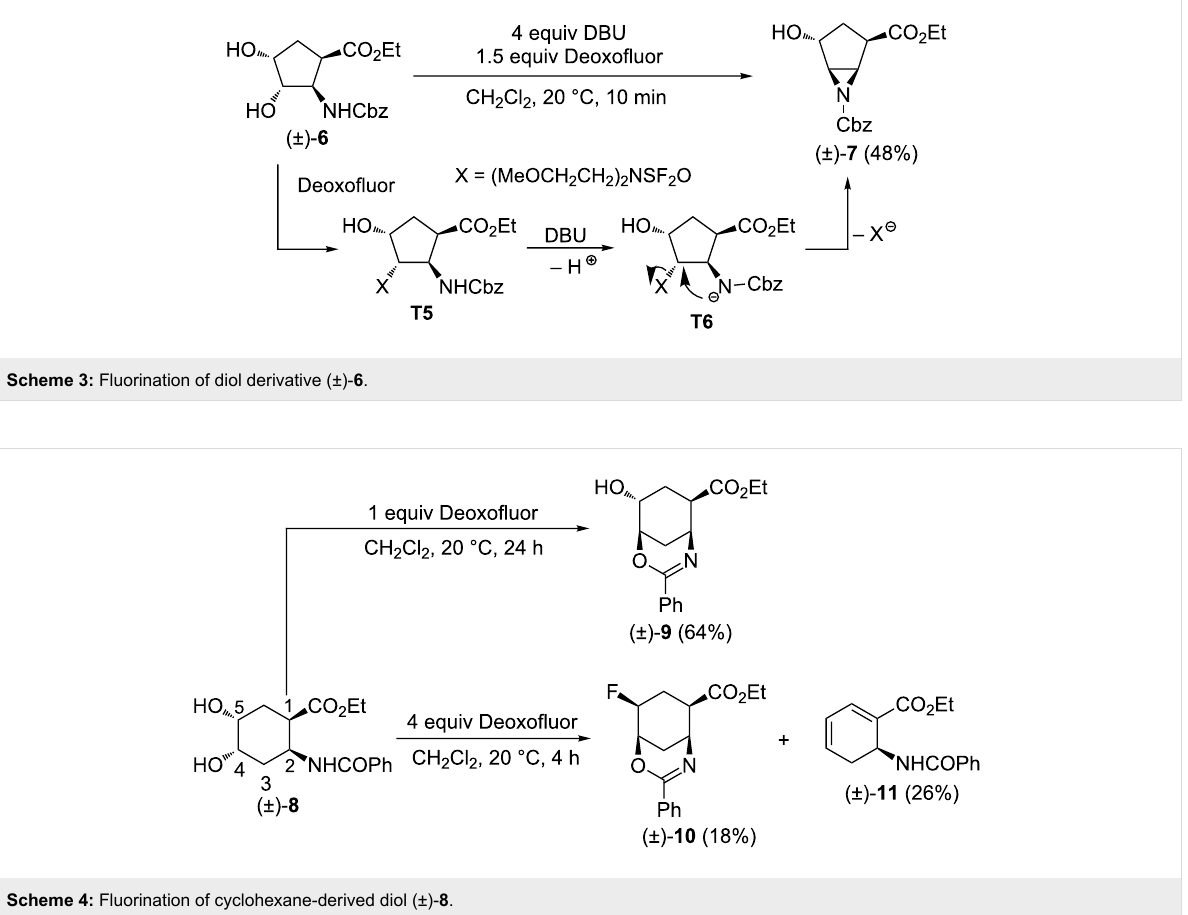
alcoholic group at C-4 in (±)- 8 into a leaving group, an intramo- lecular cyclization takes place to afford oxazine (±)- 9 . Subse- quently, this oxazine, in the presence of an excess Deoxofluor gives fluorinated derivative (±)- 10 . Finally, in the presence of fluoride as base, deprotonation ( T9 ), followed by oxazine-ring